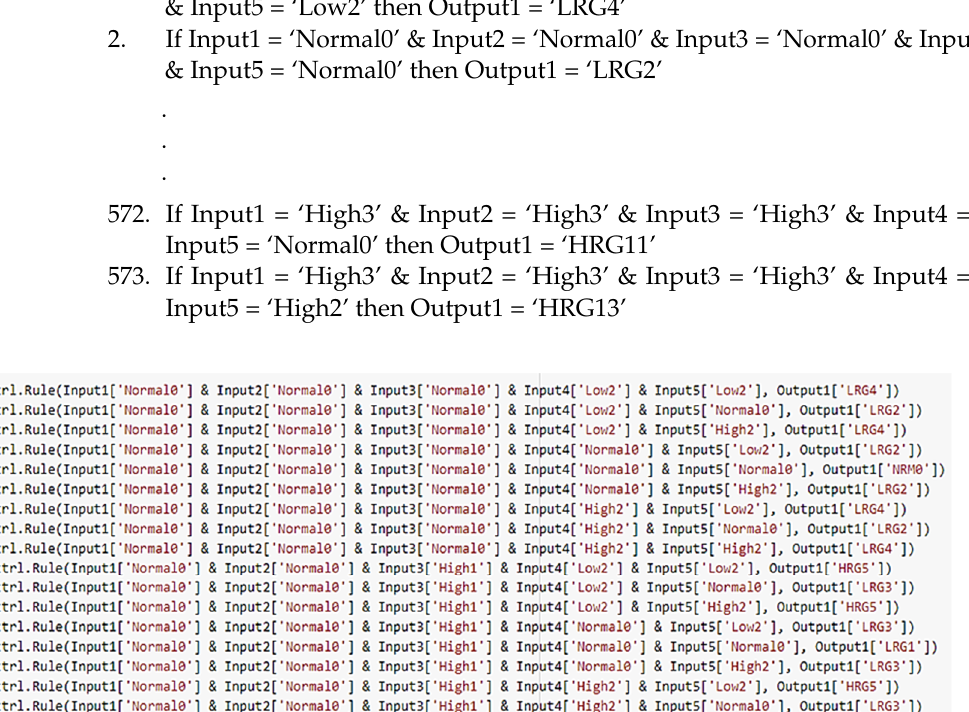
Figure 8. RG membership functions.